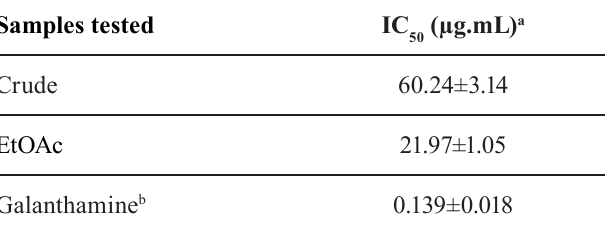
TABLE III – Percentage of inhibition of the samples tested at 100